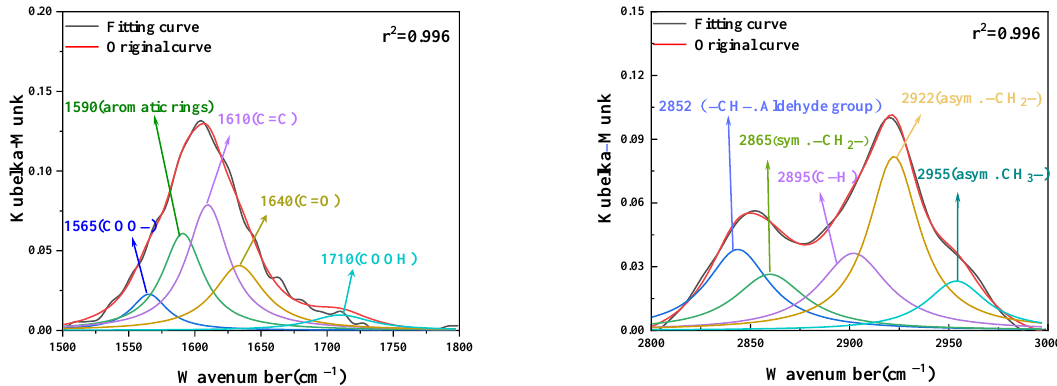
Figure 11. FTIR spectra of coal samples at different temperatures. The results of peak fitting based on the FTIR spectra are shown in Figure 12, and variations of CH 3 , C=O, COOH functional groups in HYH and CQ coal samples are illus- trated in Figures 13 – 15.